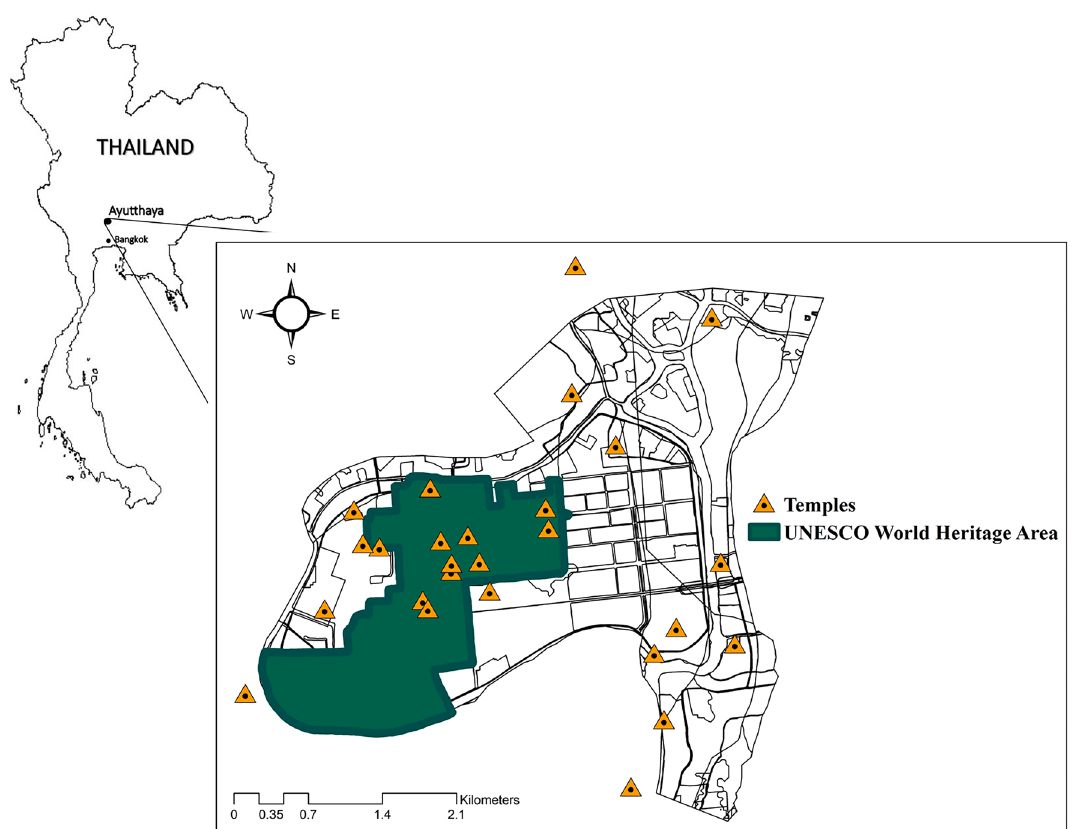
Figure 1. Research case study, Ayutthaya Municipality, Thailand (modified from 9 ).